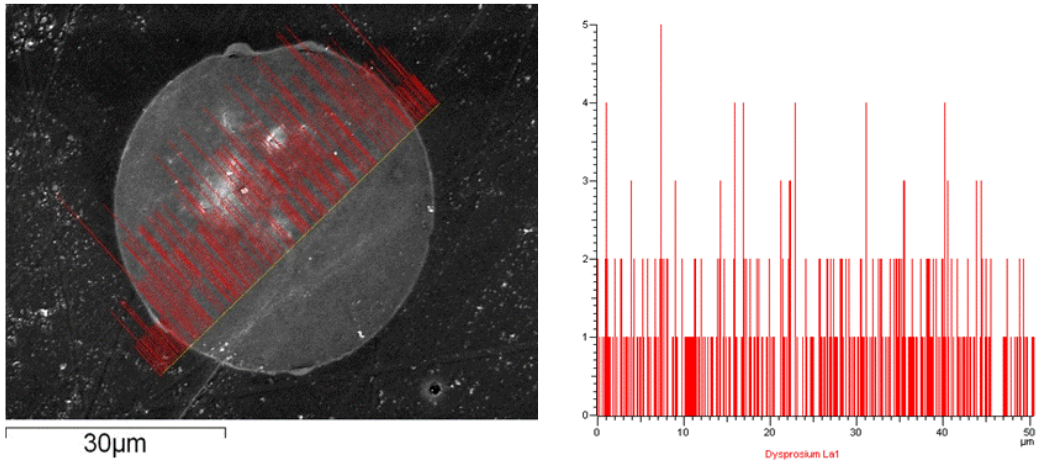
Figure 5. SEM-EDS of Dy(III)-loaded iso BTP/SiO 2 -P after batch adsorption for 1 h.